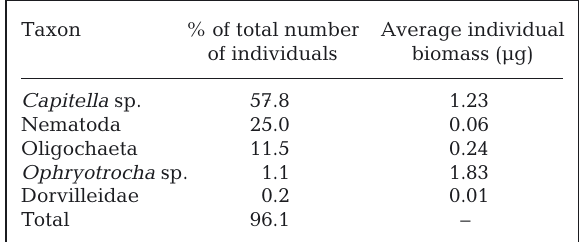
Table A1. Numerically dominant fauna with proportion that each taxon comprised out of the total number of individuals (for the entire dataset), measured average individual